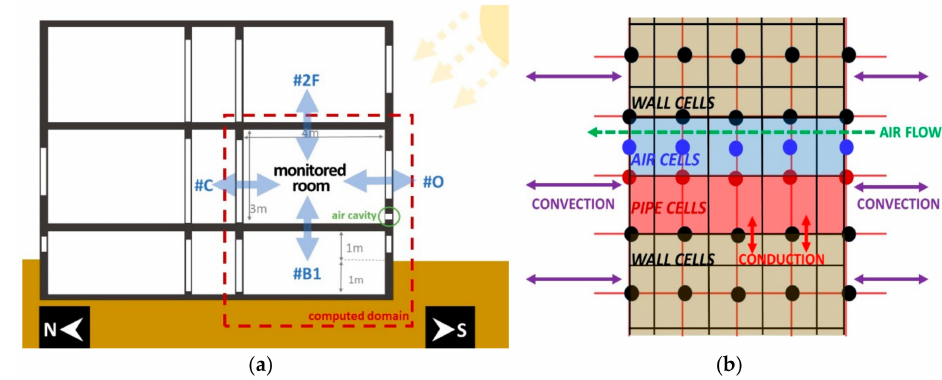
Figure 7. Simulated model: ( a ) computed domain; ( b ) pipe and air cells.